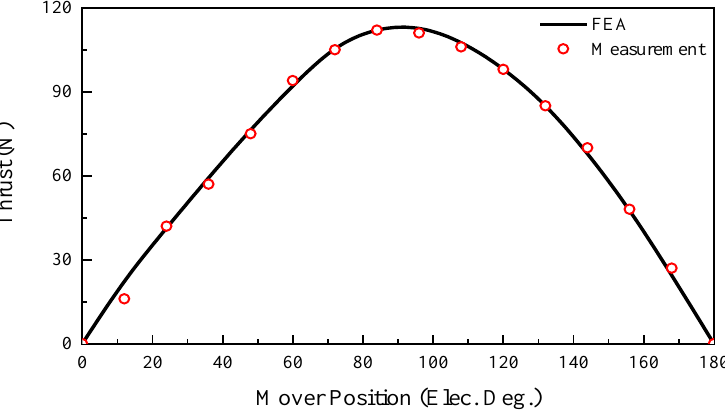
Figure 14. No-load line-to-line back-EMF at 1.0 m/s.